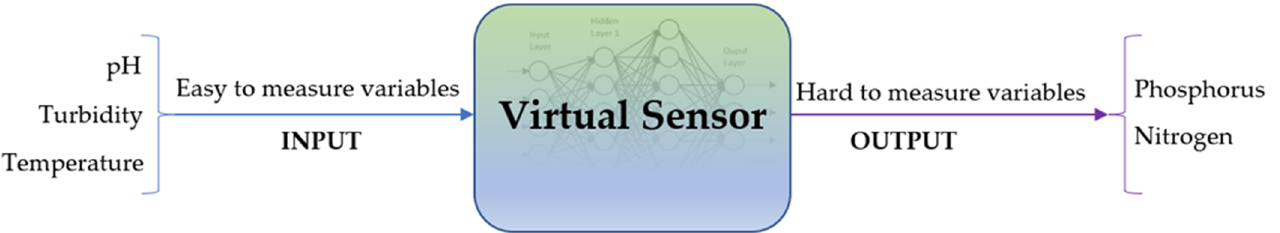
Figure 1. A working principle of the virtual sensing system.